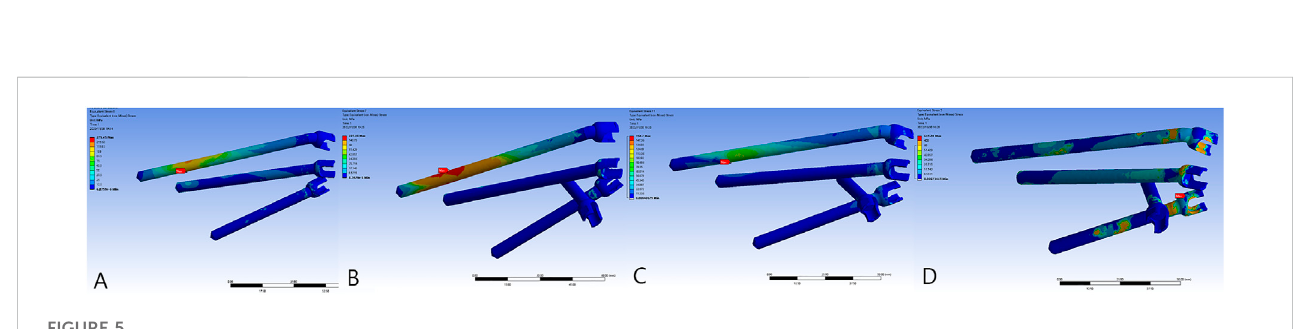
Frontiers in Bioengineering and